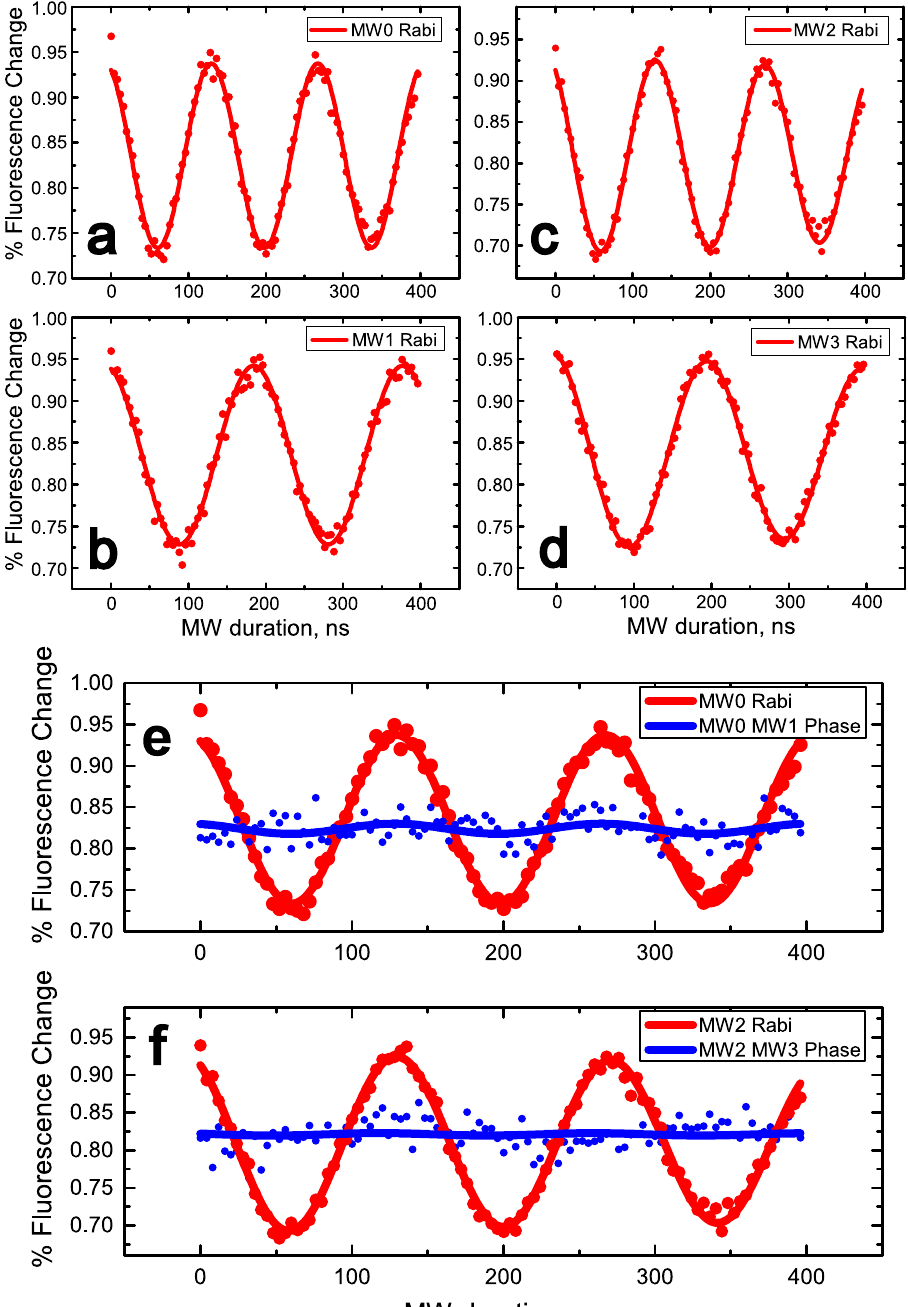
Figure 3. Rabi oscillations carried out by the four MW channels. ( a ) MW 0 . ( b ) MW 1 . ( c ) MW 2 . ( d ) MW 3 . ( e ) Red line shows the Rabi oscillation carried out by MW 0 . Blue line shows the Rabi oscillation carried out by MW 1 after a MW 0 π pulse. ( f ) Red line shows the Rabi oscillation carried out by MW 2 . Blue line shows the Rabi 2 oscillation carried out by MW 3 after a MW 2 π 2